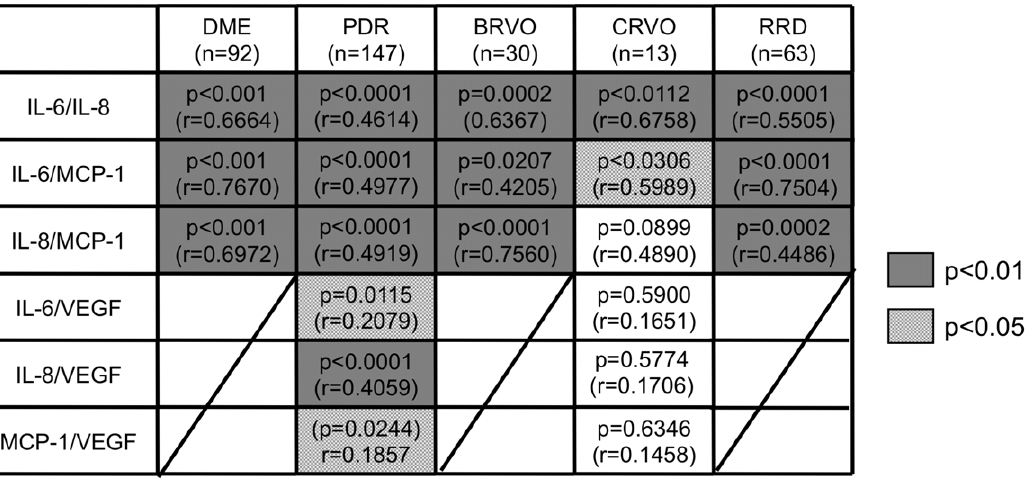
Figure 3. Summary of correlation analysis. The combination of two factors was calculated for each individual disease and listed in the ordinate.